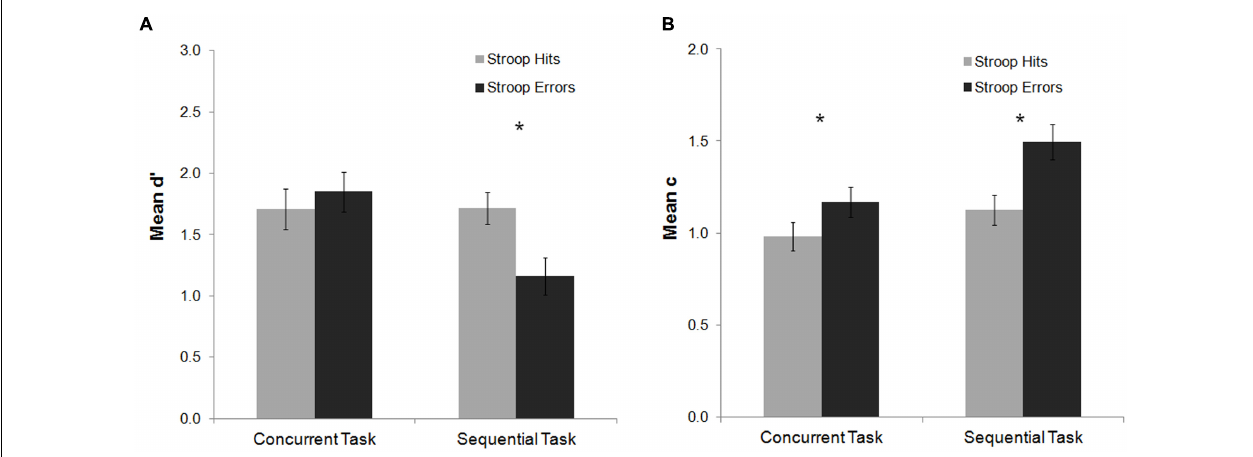
FIGURE 5 | Mean d (cid:48) and c indexes as a function of task and Stroop response accuracy in Experiment 2. For the d (cid:48) index (A) , committing an error in the Stroop task impaired participants’ perceptual sensitivity to detect the subsequent Gabor in the sequential task. For the c index (B) response criterion to detect the Gabor was more conservative after an error on the Stroop task as compared to hit trials for both the concurrent and the sequential task. Bars represent standard errors. Asterisks represent the significant effects for the Fisher post hoc comparisons ( p <